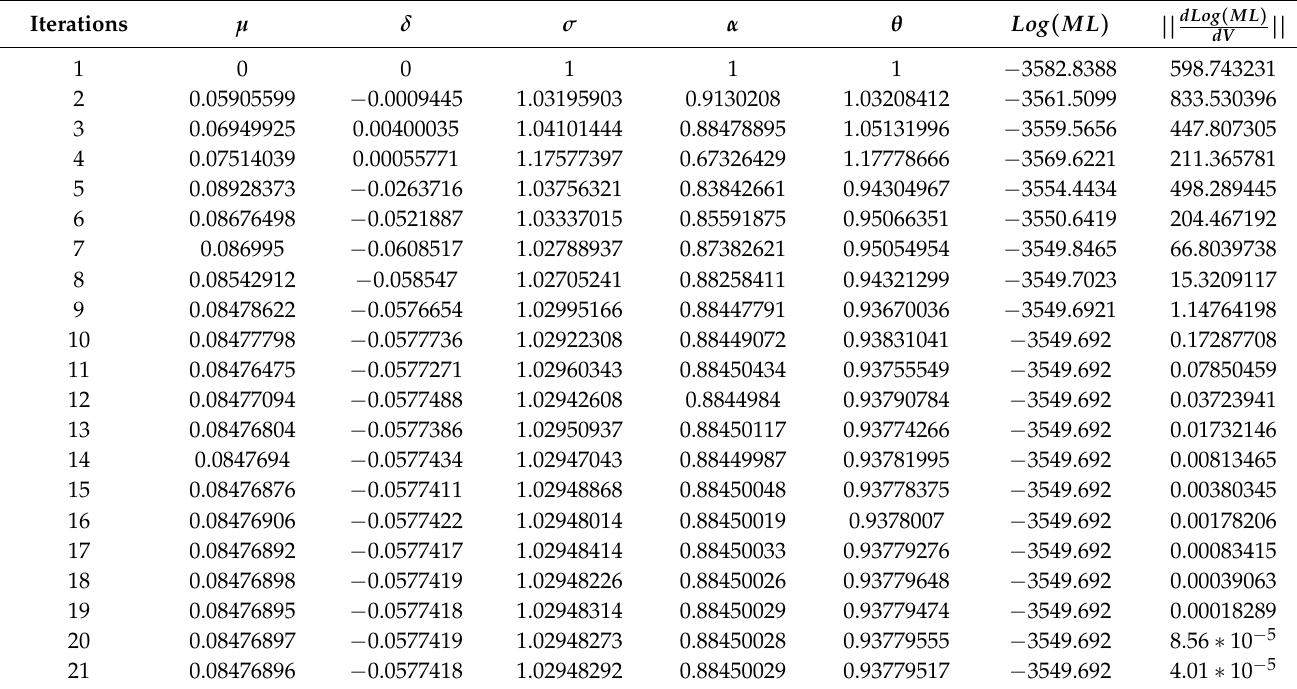
Table 2. Results of VG model parameter